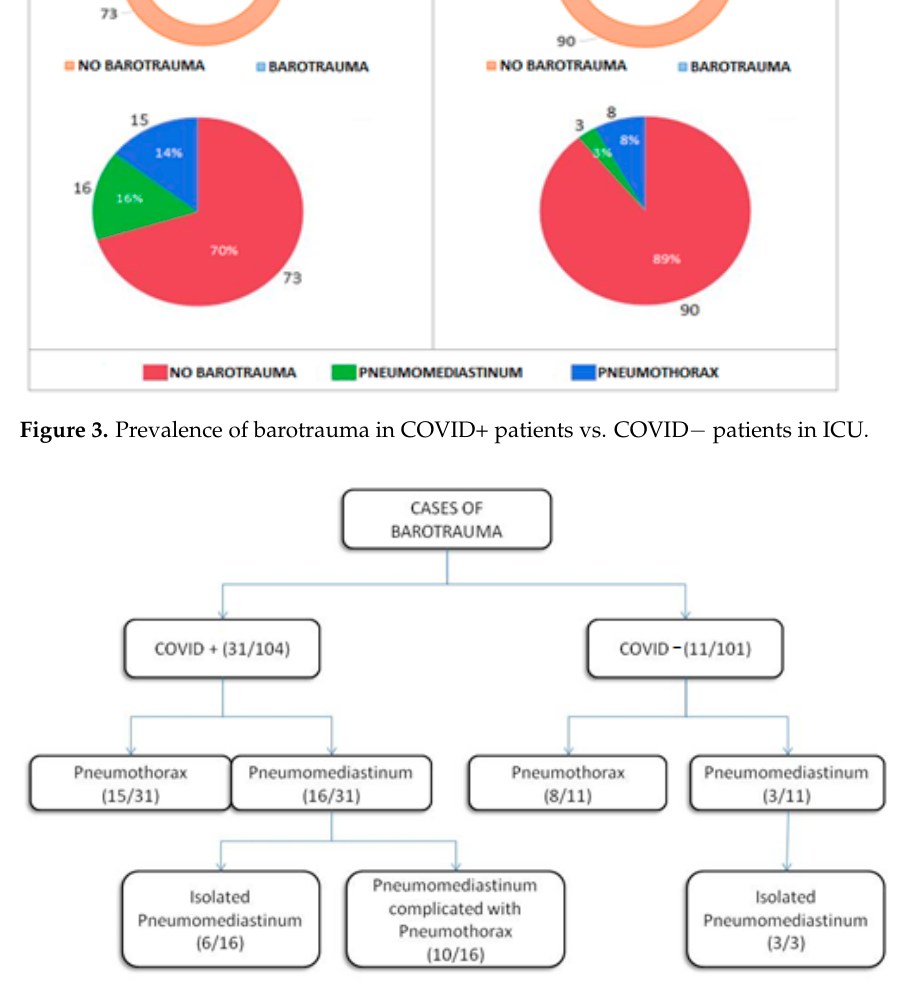
Figure 4. Types of barotrauma among groups.